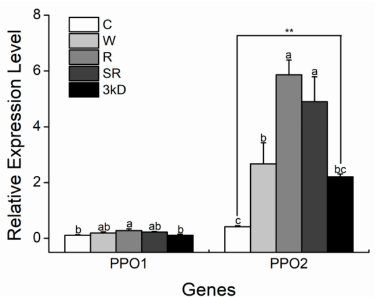
Figure 8. Mean levels of transcriptional expression ( ± SE) of CsPPO1 and CsPPO2 in treated tea leaves elicited by mechanical wounding supplemented with distilled water (W), diluted regurgitant (R), sterile extract (SR), sterile extract without 3-kDa molecules(3kD) and intact control plants (C). CsGAPDH was used as a reference gene. For each time point, different letters indicate significant differences among treatments ( p < 0.05, Duncan’s multiple range test, n = 5). The asterisks indicate significant differences between treatments and controls, ** p < 0.01, Student’s t -test, n =